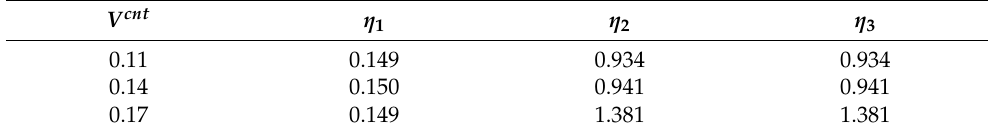
Table 1. The efficiency parameter of CNTs [4].